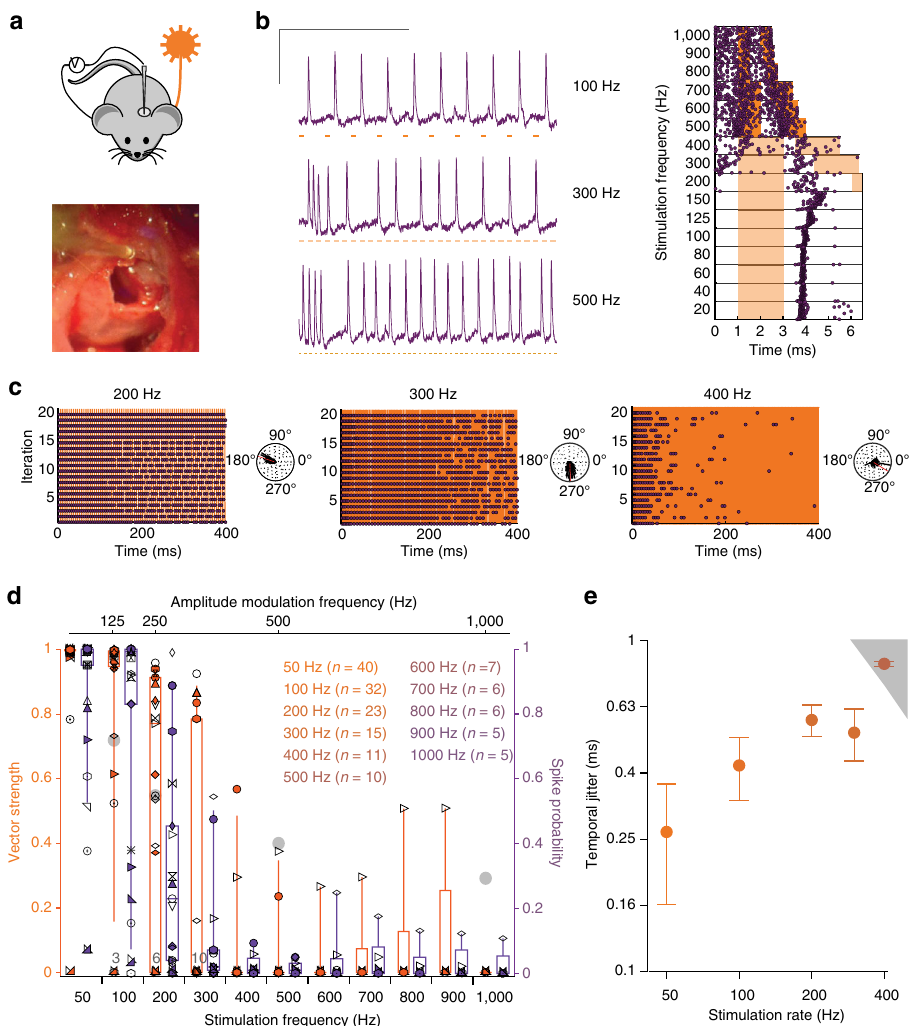
Fig. 6 f-Chrimson enables SGNs spiking at near physiological rates. a Experimental set-up for recording optogenetic responses of SGNs in mice: a 50 µ m optical fi ber coupled to a 594 nm laser was implanted into scala tympani via the round window (lower panel, see cylindrical structure in the upper half) and microelectrodes were advanced into the cochlear nucleus via a craniotomy (upper panel). b Exemplary spikes of a neuron (1 ms, 5.5 mW for 100, 300 Hz; 11 mW for 500 Hz). Raster plot (right panel): spike times in response to laser pulses (orange bars: 2 ms @5.5 mW for 20-400 Hz, 1 ms @11 mW for 500- 700 Hz and above: 0.5 ms @11 mW): spikes cluster in time for stimulus rates up to hundreds of Hz, temporal jitter increases with stimulation rates. Scale bar: 50 ms, 2 mV. c Activity of an exemplary neuron in response to 900 ms trains of laser pulses (1 ms) at three different rates leaving an inter-train recovery time of 100 ms ( fi rst 400 ms are shown and analyzed). Panels to the right side of raster plots show polar plots: synchronicity and probability of fi ring decay with increasing stimulus frequency. Spike probability 200 Hz: 0.8, 300 Hz: 0.33, 400 Hz: 0.04. Vector strength 200 Hz: 0.92, 300 Hz: 0.83, 400 Hz: 0.57 (Rayleigh-test: P < 0.001 in all cases). d Box-whisker plots showing 10th, 25th, 50th, 75th and 90th percentiles of the vector strength (orange) and spike probability (purple) of 40 units from fi ve mice, stimulated at different rates as described for c . Symbols represent values from every unit. Gray circles are means of vector strength of SGNs in wild-type mice found with transposed tones at the characteristic frequency at 30 dB relative to spike threshold 36 , for comparison. Numbers at the bottom of the graph indicate number of units clustered below them. e Temporal jitter of spikes across stimulation rates 50 – 400Hz. Gray area represents the hazard function obtained in response to simulated Poisson spike trains. Data points show mean (lines) ± s.e.m. (error bars). Number of units included for each stimulation frequency (color coded) is